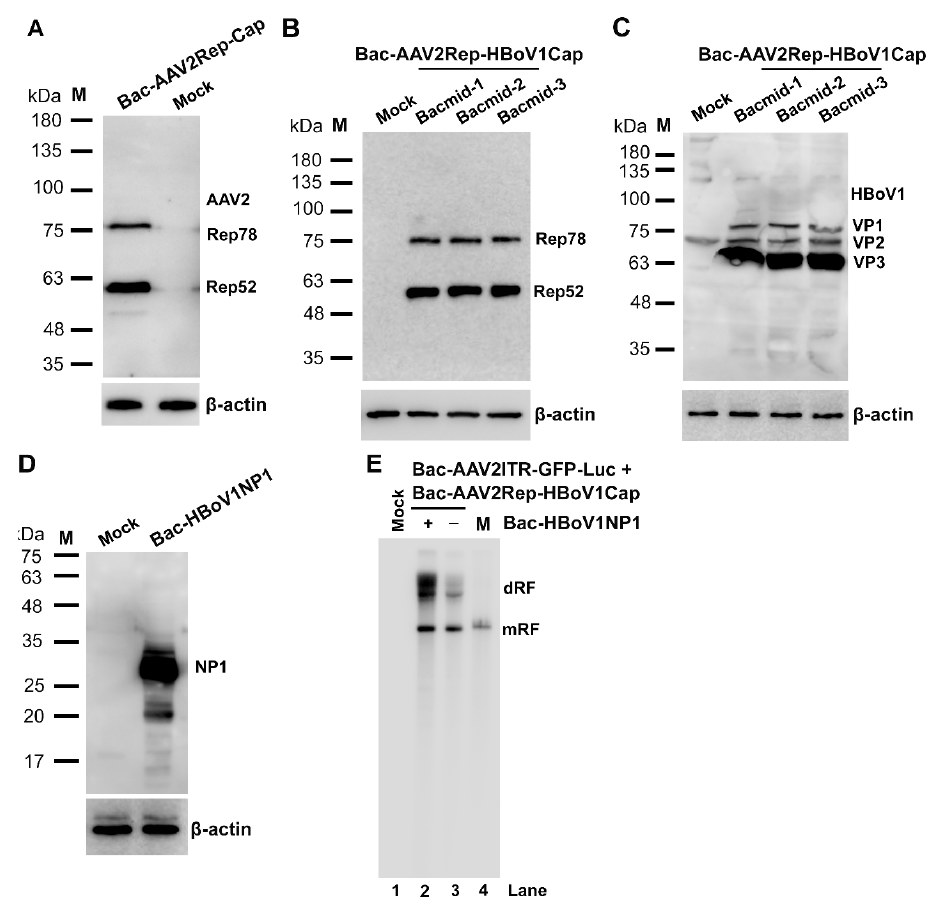
Figure 2. Expression of AAV2 Rep and Cap proteins and HBoV1 Cap and NP1 proteins in BEV-infected Sf9 cells. ( A – D ) Western blotting. Sf9 insect cells were infected with Bac-AAV2Rep-Cap ( A ), Bac-AAV2Rep-HBoV1Cap ( B , C ), or Bac-HBoV1NP1 ( D ). The infected cells were collected at 72 hrs post-infection and subjected to Western blot analysis. ( A ) AAV2 Rep proteins were detected with an anti-Rep monoclonal antibody. ( B , C ) Bac-AAV2Rep-HBoV1Cap generated from transfection of three bacmid (Bacmid-1-3) were infected with Sf9 cells independently. ( B ) AAV2 Rep proteins were detected with an anti-Rep monoclonal antibody, and ( C ) HBoV1 Cap protein expression was detected with an anti-HBoV1 Cap protein antiserum. ( D ) HBoV1 NP1 was detected with a rat anti-HBoV1 NP1 antiserum. β -actin served as a loading control. Mock, uninfected cells. ( E ) Southern blotting. Sf9 cells were infected with Bac-AAV2ITR-GFP-Luc and Bac-AAV2Rep-HBoV1Cap with ( + ) or without (-) co-infection of Bac-HBoV1NP1. Cells were collected at 72 hrs post-infection and subjected to extraction of lower molecular weight (Hirt) DNAs, which were analyzed by Southern blotting. Mock, uninfected Sf9 cells as a control; M, a marker of a rAAV2ITR-GFP-Luc proviral replicative form (RF) genome